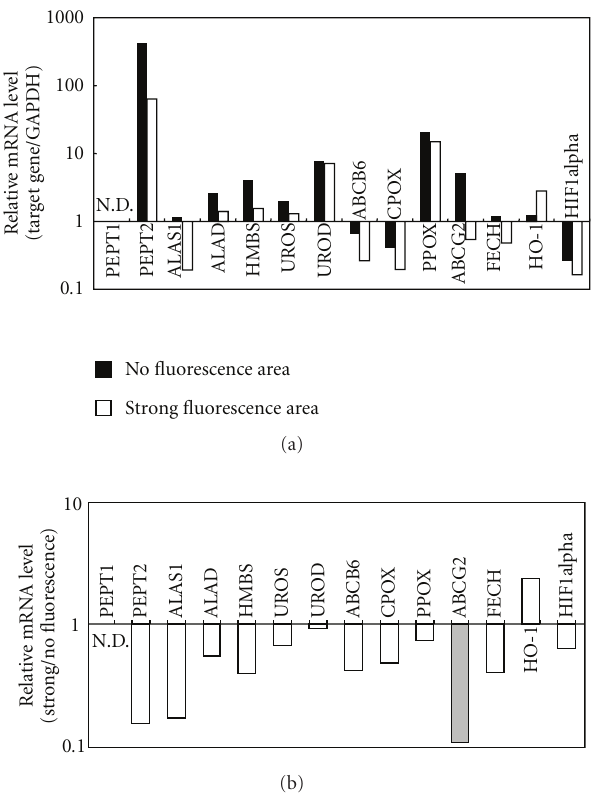
Figure 2: The mRNA levels of PEPT1, PEPT2, ALAS1, ALAD, HMBS, UROS, UROD, ABCB6 CPOX, PPOX, ABCG2, FECH, HO- 1, and HIF1alpha in malignant glioma cells in the brain tumor and in the surrounding normal cells. Total RNA was extracted from strong fluorescence-emitting areas (brain tumor) as well as from the surrounding area (mostly normal tissue) without porphyrin fluorescence. The first strand cDNA was prepared from the extracted total RNA in a reverse transcriptase (RT) reaction. (a) The mRNA levels of the genes involved in the heme synthesis and metabolism reactions were detected by quantitative PCR and normalized to the mRNA level of GAPDH. (b) The relative mRNA levels of those genes in both areas were compared, where the relative mRNA level in the strong fluorescence-emitting area (brain tumor) was divided by that in nonfluorescence area (mostly normal